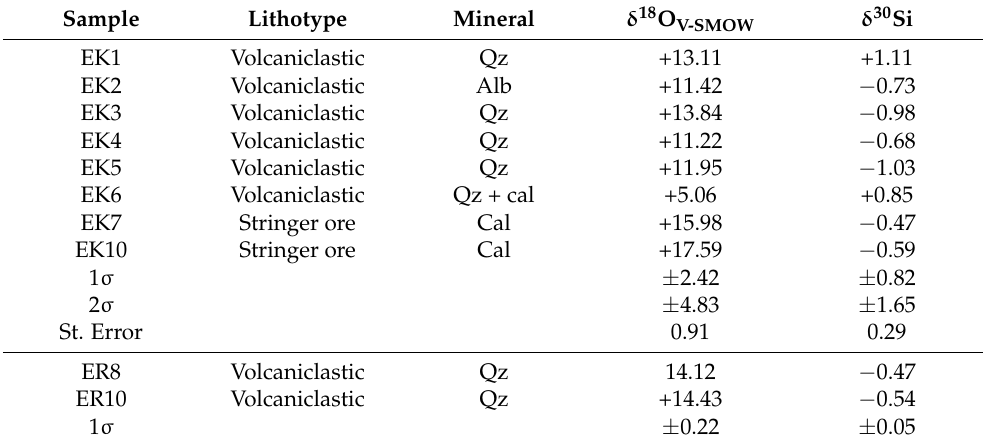
Table 2. Stable isotope data from Ermioni VMS; oxygen and silicon isotopic data were obtained